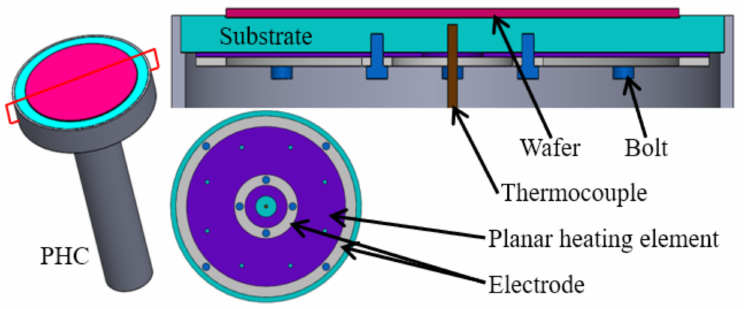
Figure 2. PHC structures designed in our previous study [14]. ©2020 The Japan Society of Ap- plied